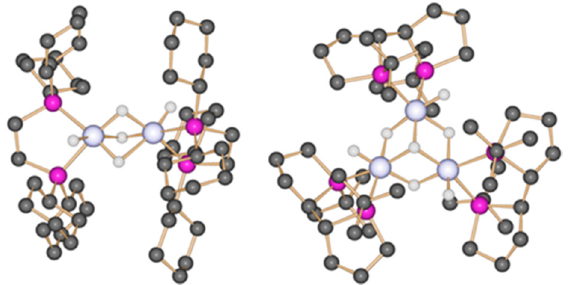
Figure 10. Molecular structure of the hydride complexes {[Rh(DCPE)H] 2 ( µ 2 -H) 3 } + , left, and {[Rh(Tangphos)H] 3 ( µ 2 -H) 3 ( µ 3 -H)} 2+ , right. Hydrogen atoms are omitted for clarity.